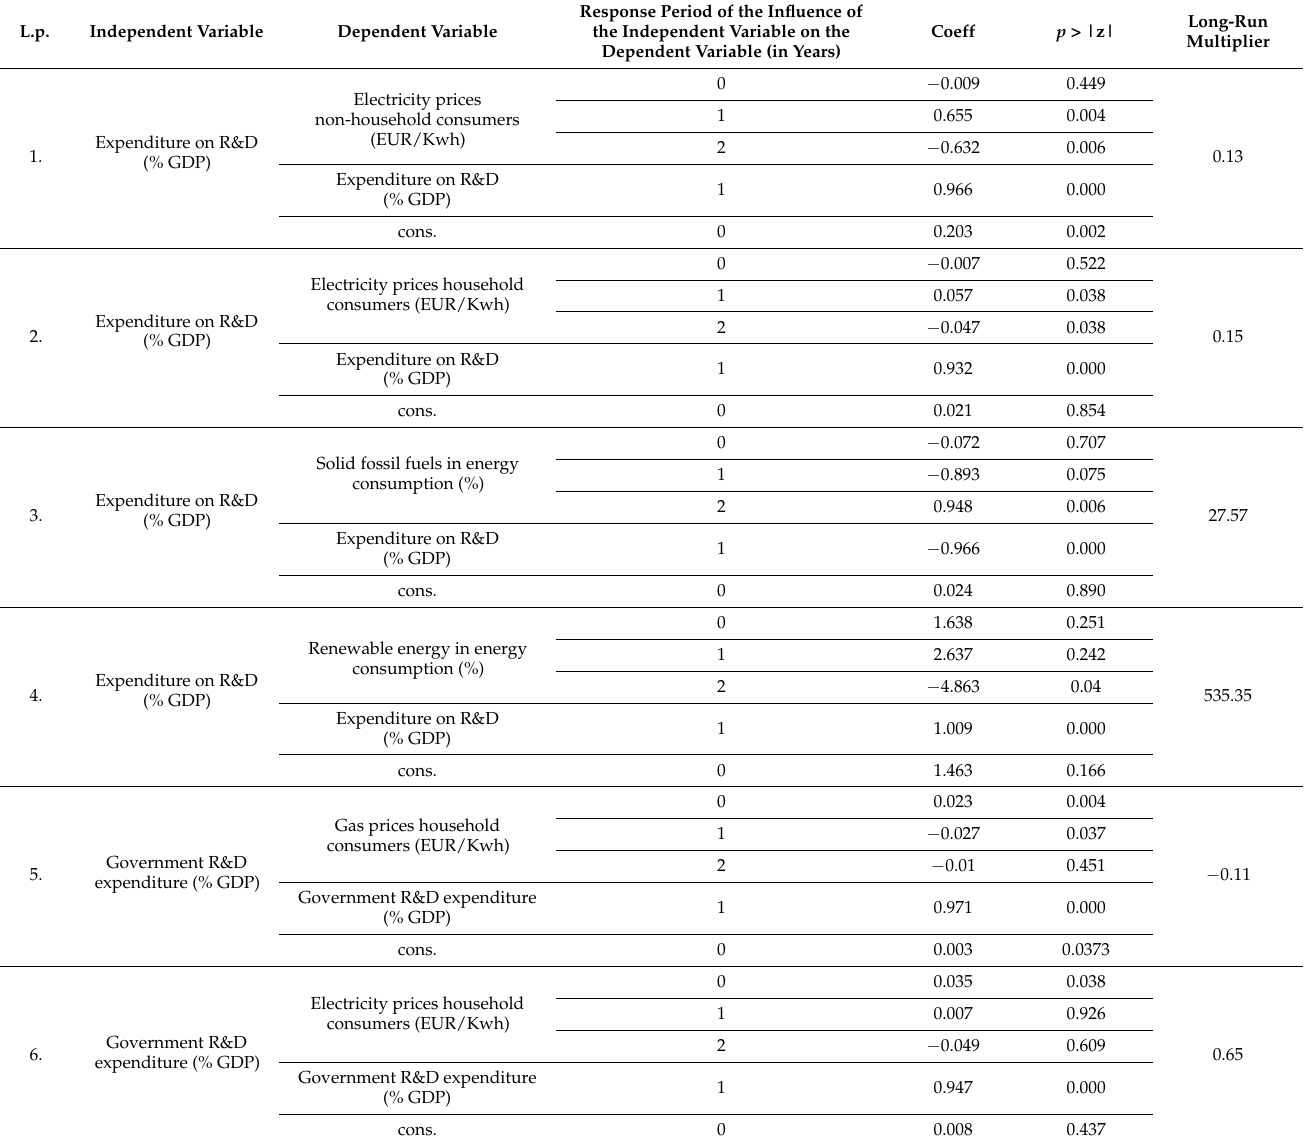
Table 5. Relationships between different categories of expenditure on R&D and dependent